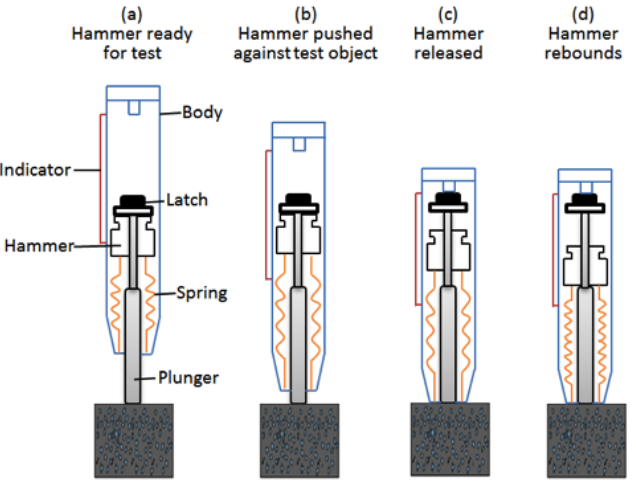
Figure 1. Rebound hammer test process.